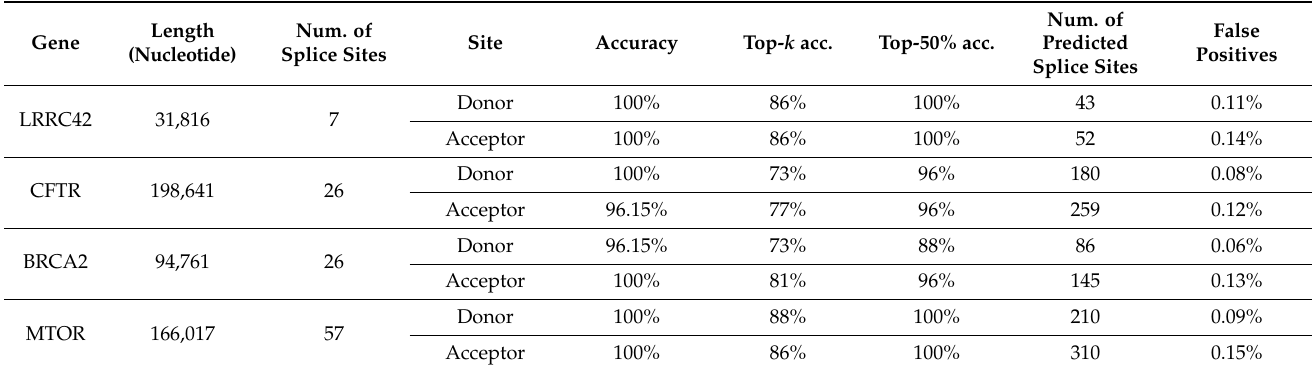
Table 8. Prediction results of human genes evaluated using Deep Splicer.